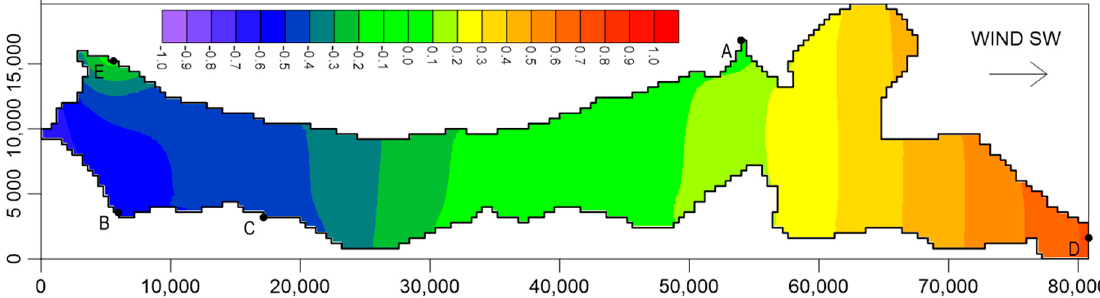
Figure 13. Water surface elevation (m a.s.l.) after 12 h of a SW wind at a speed of 12 m s − 1 and with the new artificial strait at point E (dimensions in meters).